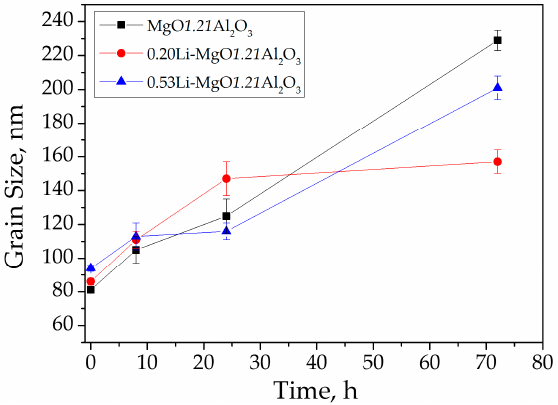
Figure 10. Grain sizes vs. annealing time of undoped, 0.2 and 0.53 at. % Li-doped MgO·1.21Al 2 O 3 samples at 1300 °C.